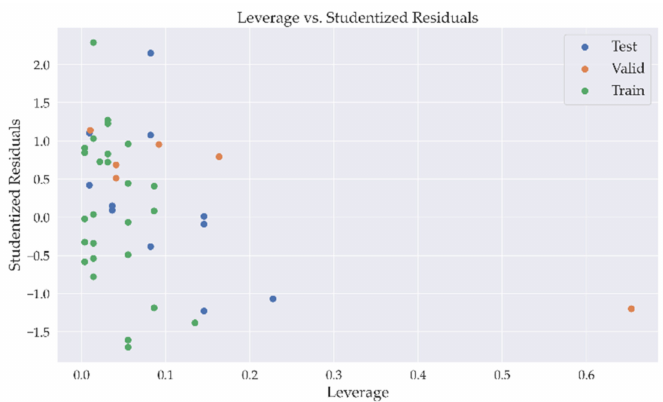
Figure 15. Model_2—Explosive charge mass–leverage vs. residuals.